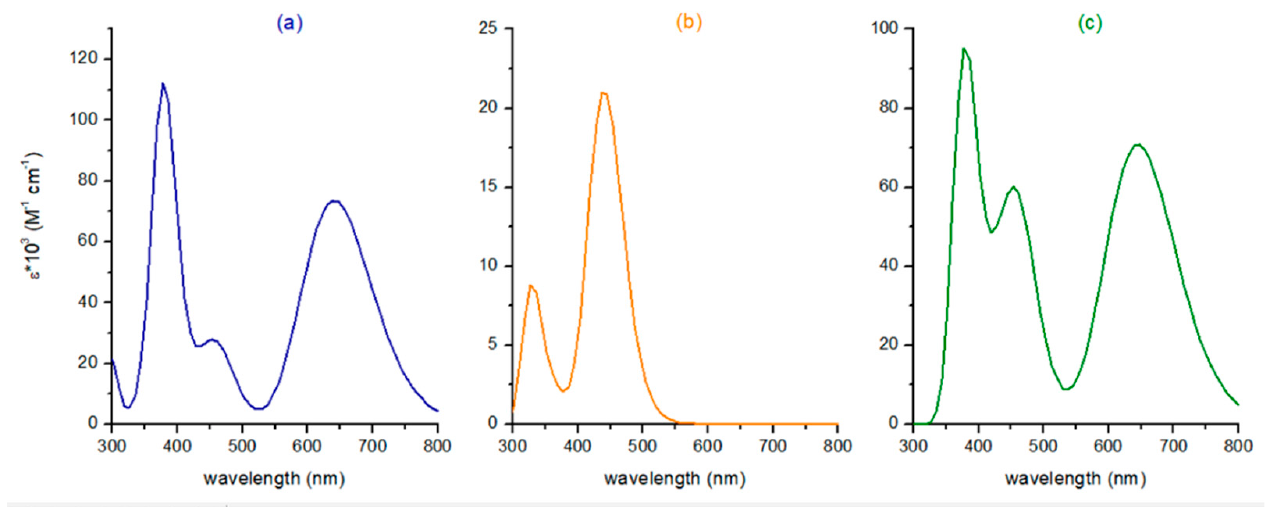
Figure 1. Calculated UV–vis absorption spectra of ( a ) BDP, ( b ) Ru, and ( c ) Ru-BDP in water at B3LYP/6-31+G* (SDD for Ru) level of theory.